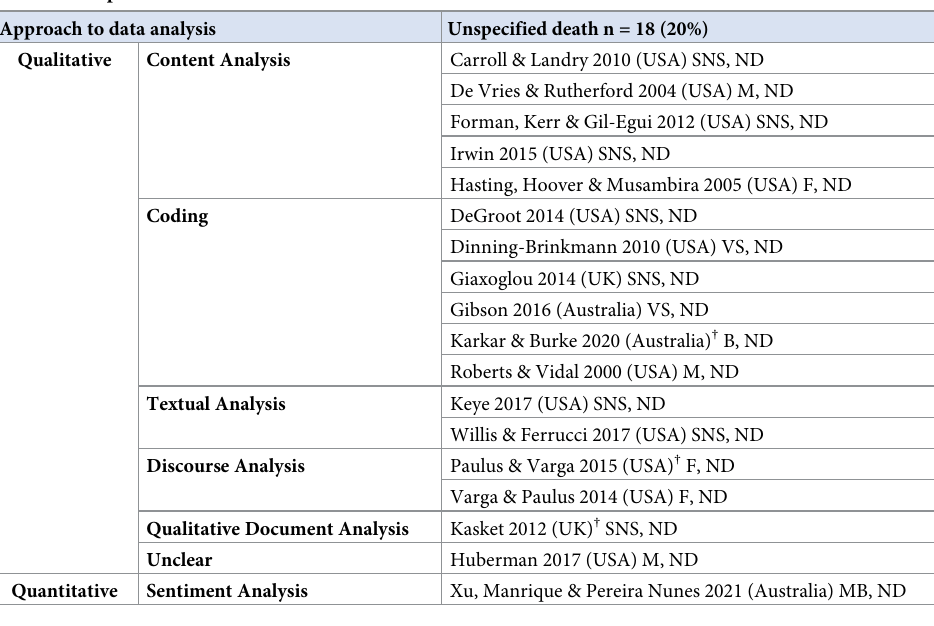
Table 4. Unspecified